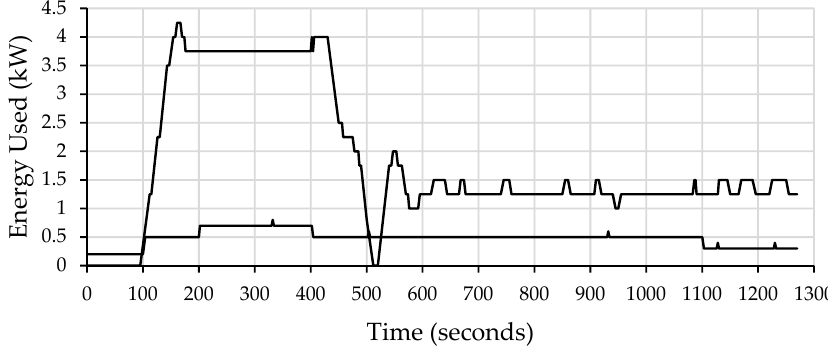
Figure 8. Auxiliary energy demand during the first 21 min.